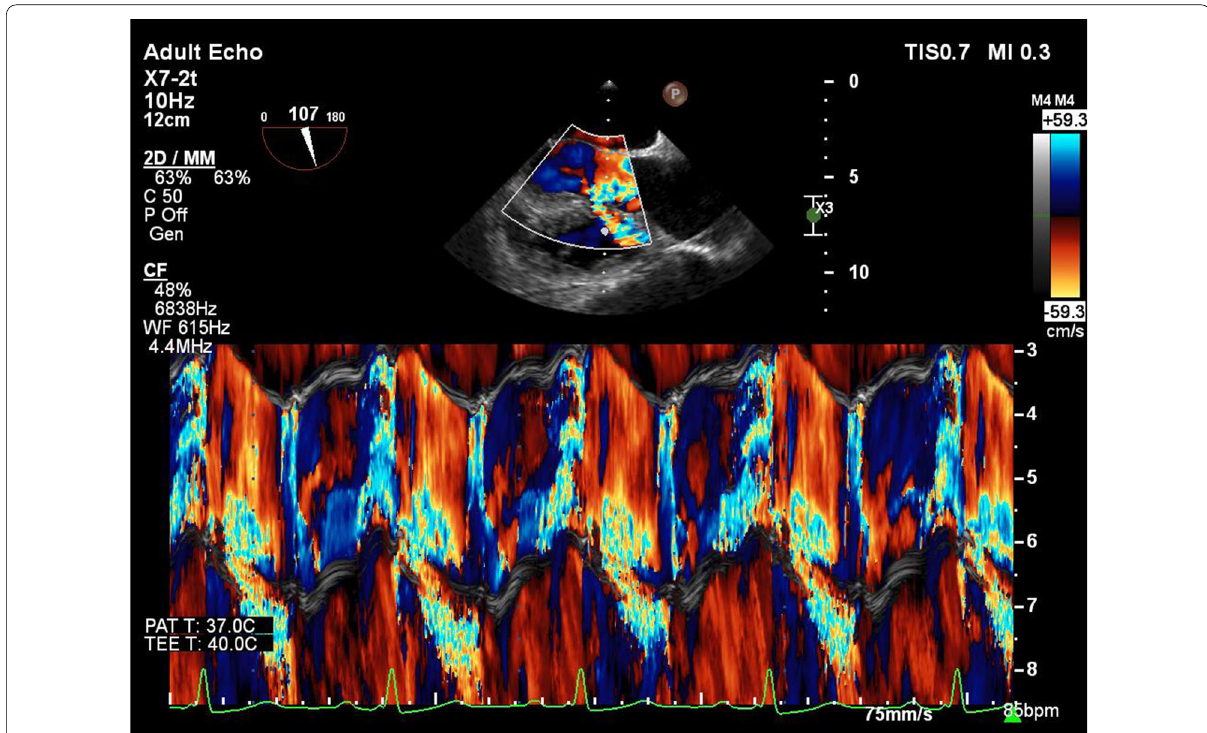
Fig. 1 2D-TEE, Color-coded M-mode showing the aortic insufficiency (AI) signal during diastole, and the perimembranous VSD signal during